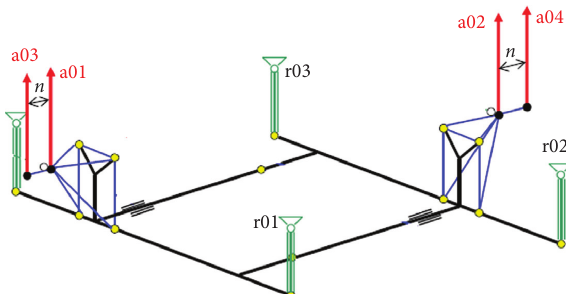
Figure 5: Load direction of motor hanger.